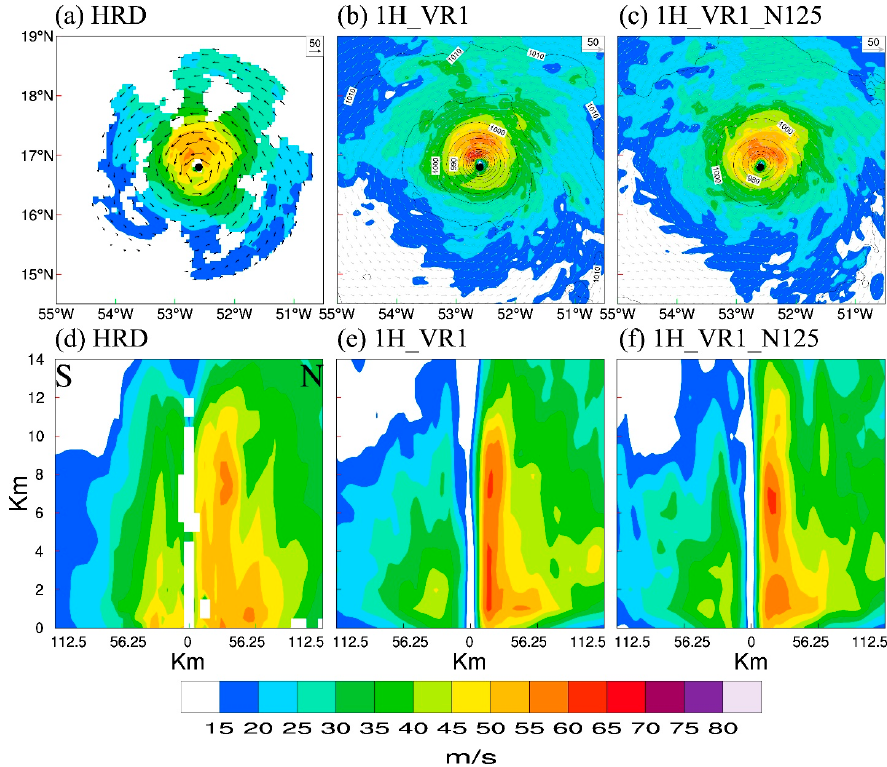
Figure 9. Same as Figure 3, except for ( b , e ) “1H_VR1” and ( c , f ) “1H_VR1_N125”.